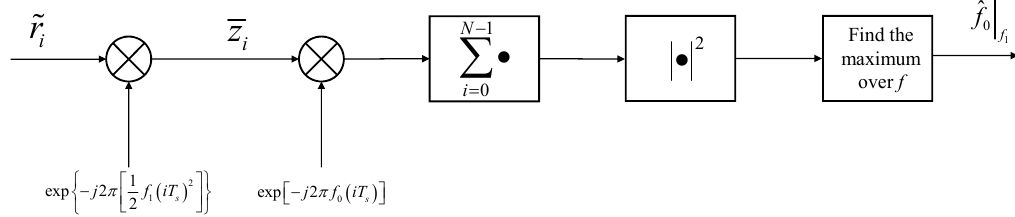
Figure 1. Block diagram of two-dimensional (2D) maximum energy search.